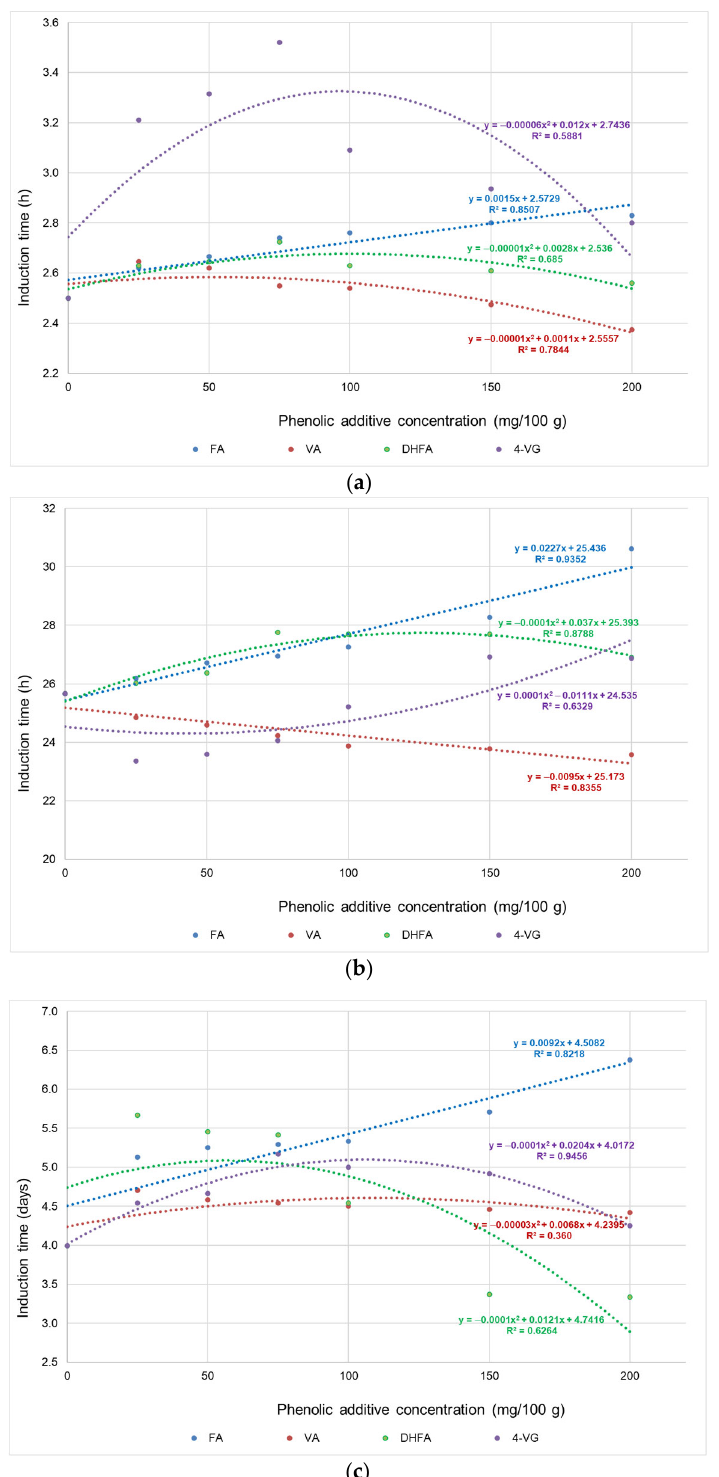
Figure 1. Induction time of cold ‐ pressed flaxseed oil with the addition of phenolic additives (FA—ferulic acid, VA—vanillic acid, DHF—dihydroferulic acid, and 4 ‐ VG—4 ‐ vinylguaiacol) determined at 110 °C ( a ), 80 °C ( b ), and 60 °C ( c ).